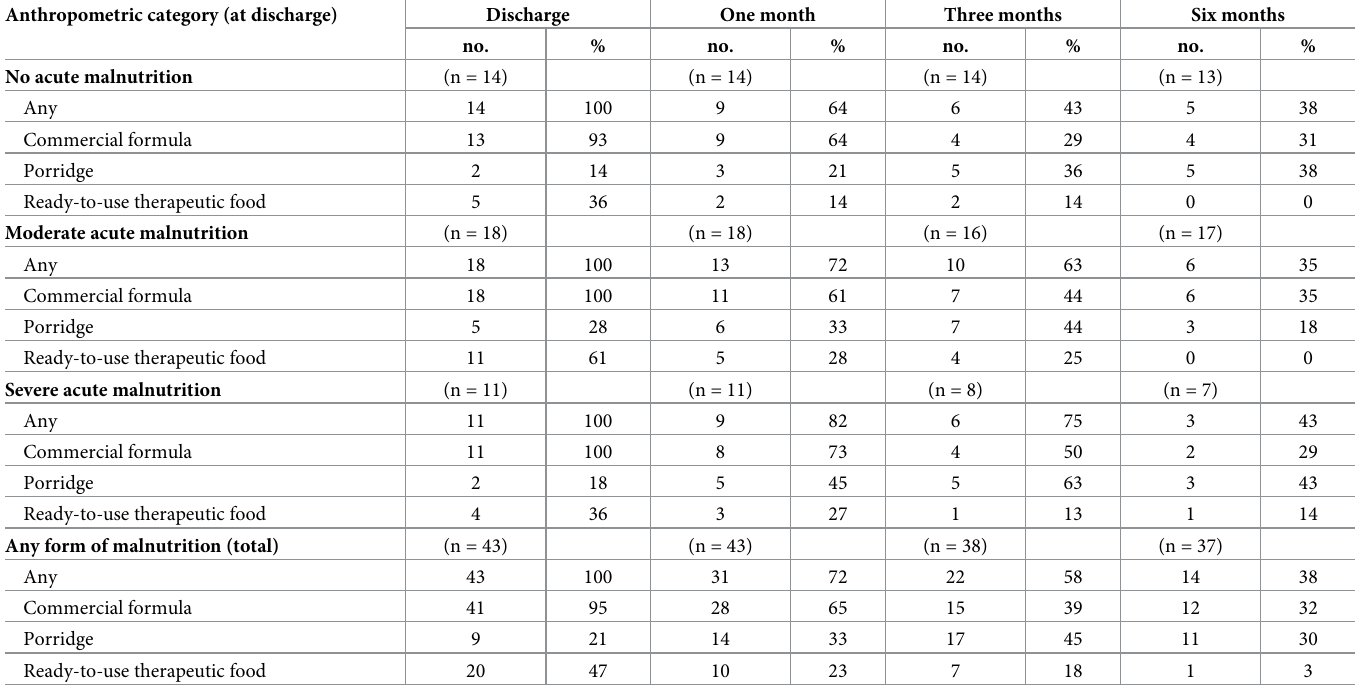
Table 4. Provision of nutritional supplements based on discharge anthropometric status and type of supplement. Anthropometric category (at